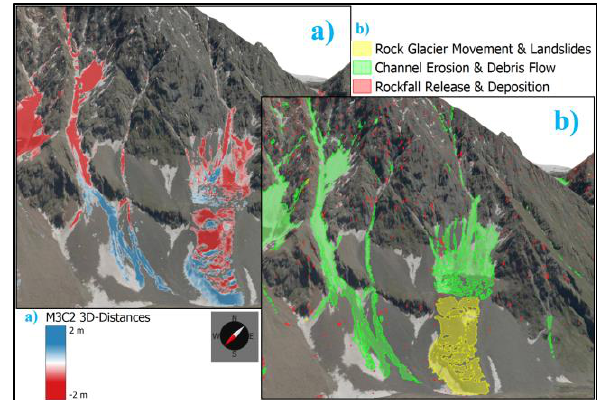
Figure 8 . a) M3C2 3D distances and b) classified real changes in Schrankar between 2006 and 2017. Orthophoto WMS for Tyrol/Austria: Federal State of Tyrol, 2021.